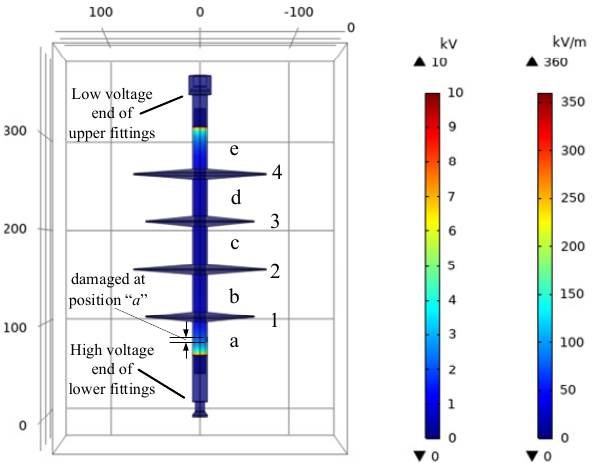
Figure 2. Calculation model of the composite insulator damaged at: ( a ) position “ a ”; ( b ) position “ b ”; ( c ) position “ c ”; ( d ) position “ d ”; and ( e ) position “ e ”; ( f ) model of the damage zone.